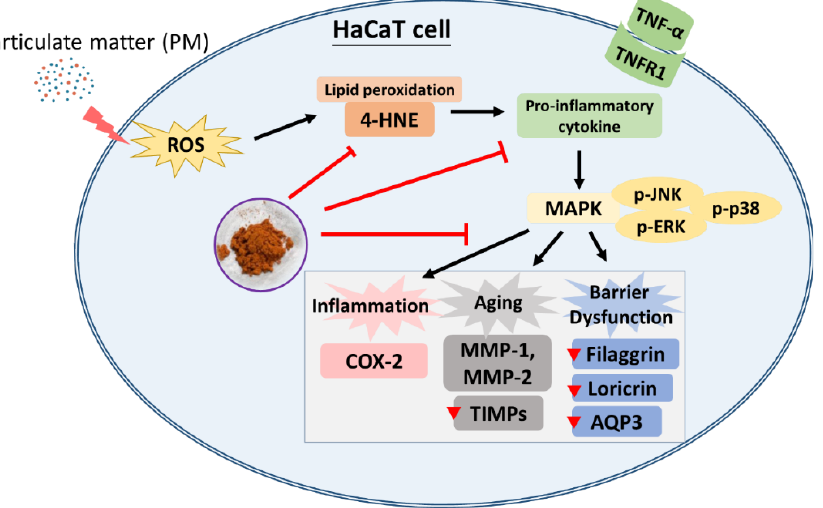
Figure 8. A proposed skin protection mechanism of AAM on PM-induced HaCaT